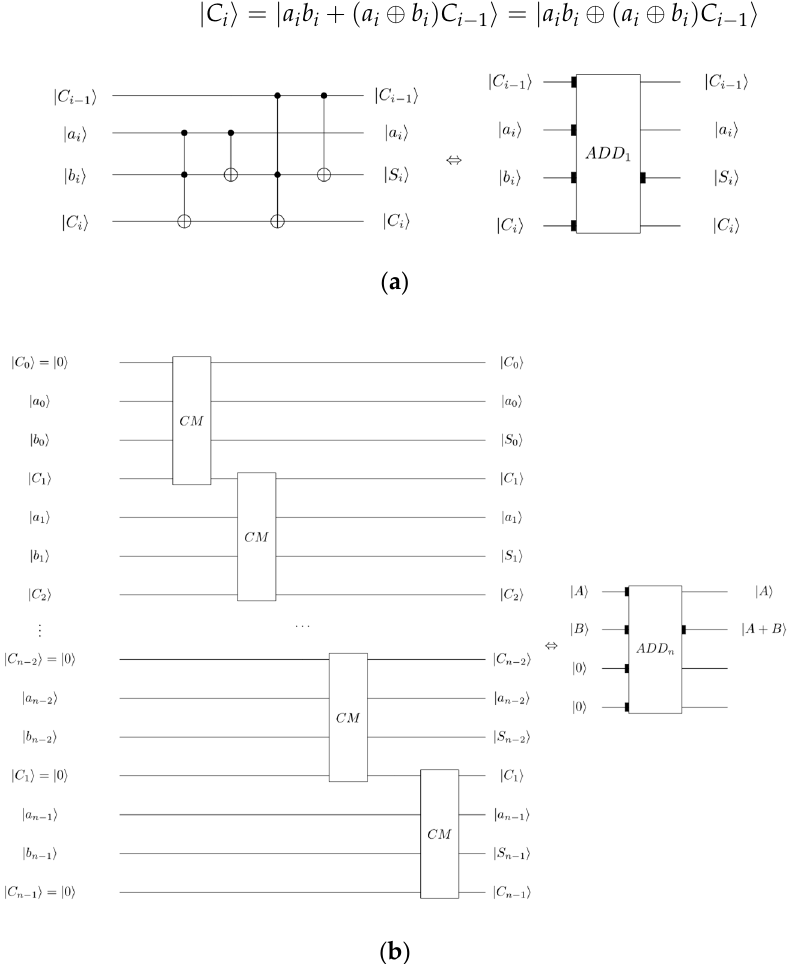
Figure 8. Full addition circuit. ( a ) 1-bit full addition circuit. ( b ) n-bit full addition circuit.